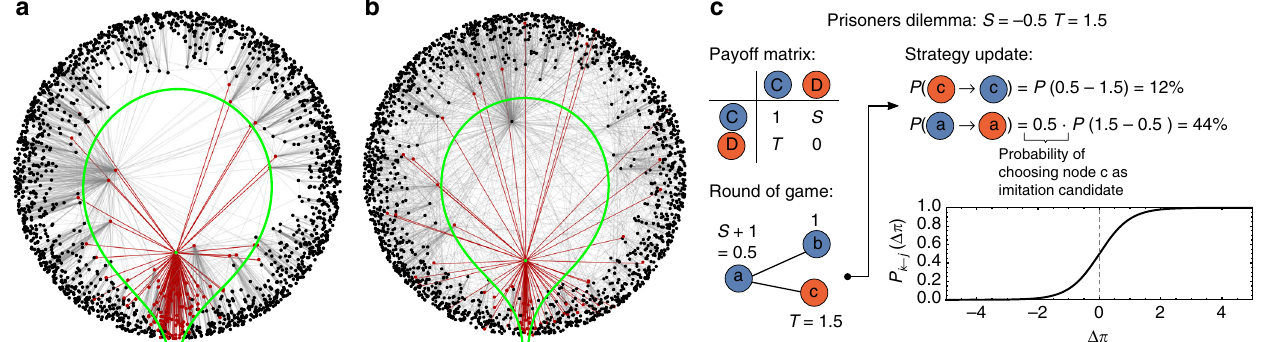
Fig. 1 Evolutionary dynamics on scale-free networks embedded into hyperbolic space. a Illustration of the hyperbolic spatial structure (Poincaré Disc) underlying a synthetic network generated by the model described in Methods. The network shown here has N = 2000 nodes, a power-law exponent γ = 2.6, mean degree k h i ≈ 6, and mean local clustering coef fi cient c ¼ 0 : 6 (temperature T ¼ 0 : 3 as in Eq. (6), see Methods section for details). Hubs, i.e. high-degree nodes, are placed closer toward the center of the disc (lower radial coordinate). The angular space represents the similarity between nodes, such that nodes tend to connect to other nodes close to them in this space. The green line shows the hyperbolic disc of radius R (Eq. (5)) around the green node. We highlight the neighbors of the green node in red. For a high c (i.e., low T ), as shown here, the green node is highly likely to connect to other nodes within the disc (green line), and very unlikely to connect to nodes outside of it (the further apart, the less probable). The high mean local clustering coef fi cient is then a consequence of the triangle inequality in the metric space. b Synthetic network generated with the same model but with mean local clustering coef fi cient c ¼ 0 : 25 (temperature T ¼ 0 : 7). We again show the hyperbolic disc of radius R (Eq. (5)) around the green node and highlight its neighbors in red. Note that due to the higher temperature more long-range connections are formed, i.e., the green node connects to more nodes outside of the disc as compared to a , and does not connect to some node inside of the disc. This effect reduces the mean local clustering coef fi cient as it induces randomness in the link formation process. c Illustration of evolutionary game dynamics. In structured populations, individuals play with their neighbors in a network. In each game, they generate a payoff given by the payoff matrix (Eq. (1)). After each round, they choose a random neighbor and imitate her strategy with a probability (Fermi – Dirac distribution) that depends on the difference between their